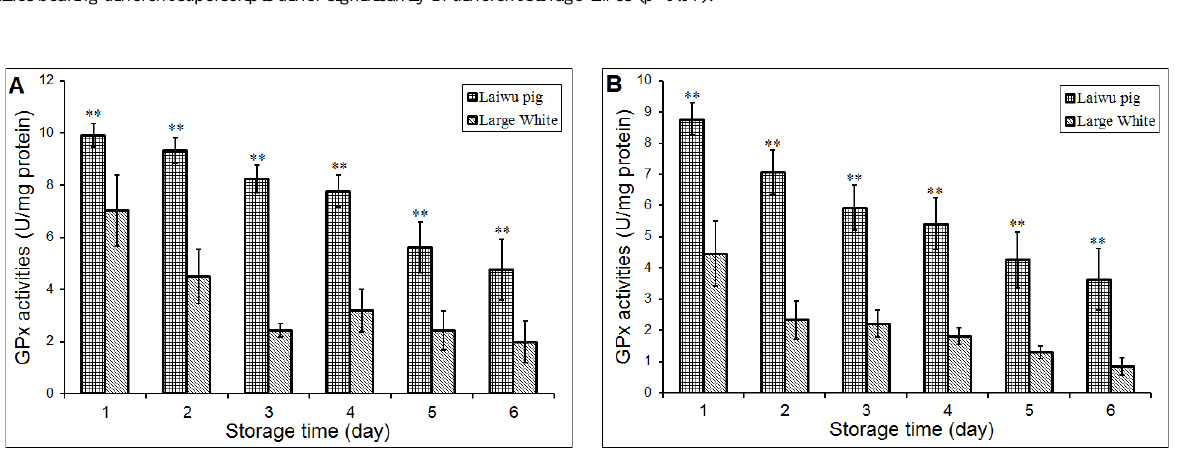
Values in each cell are mean  SEM ( n = 6). a Values bearing different superscripts differ significantly in two different storage temperatures (p<0.01). b Values bearing different superscripts differ significantly in different storage times (p<0.01).